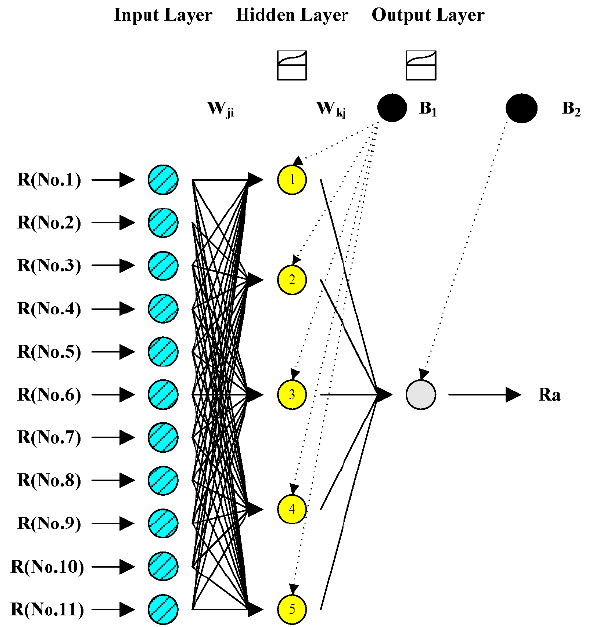
Figure 3. Structure of MLP (11-5-1) developed for estimating areal